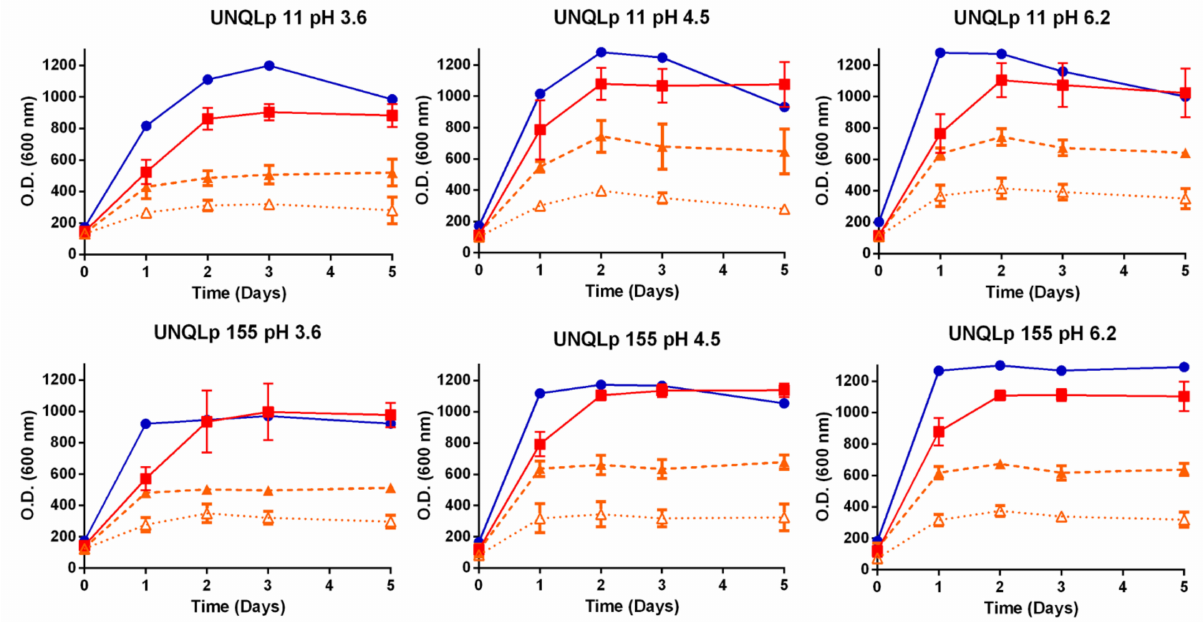
Figure 1. Growth kinetics, by OD 600nm measurement, during incubation of UNQLp 11 and UNQLp 155 strains in AP ( (cid:52) ), yeAP (supplemented with yeast extract) ( (cid:78) ), sAP (supplemented with yeast extract, salts, and Tween) ( (cid:4) ), or MRS broth ( • ), at pH 3.6, 4.5 and